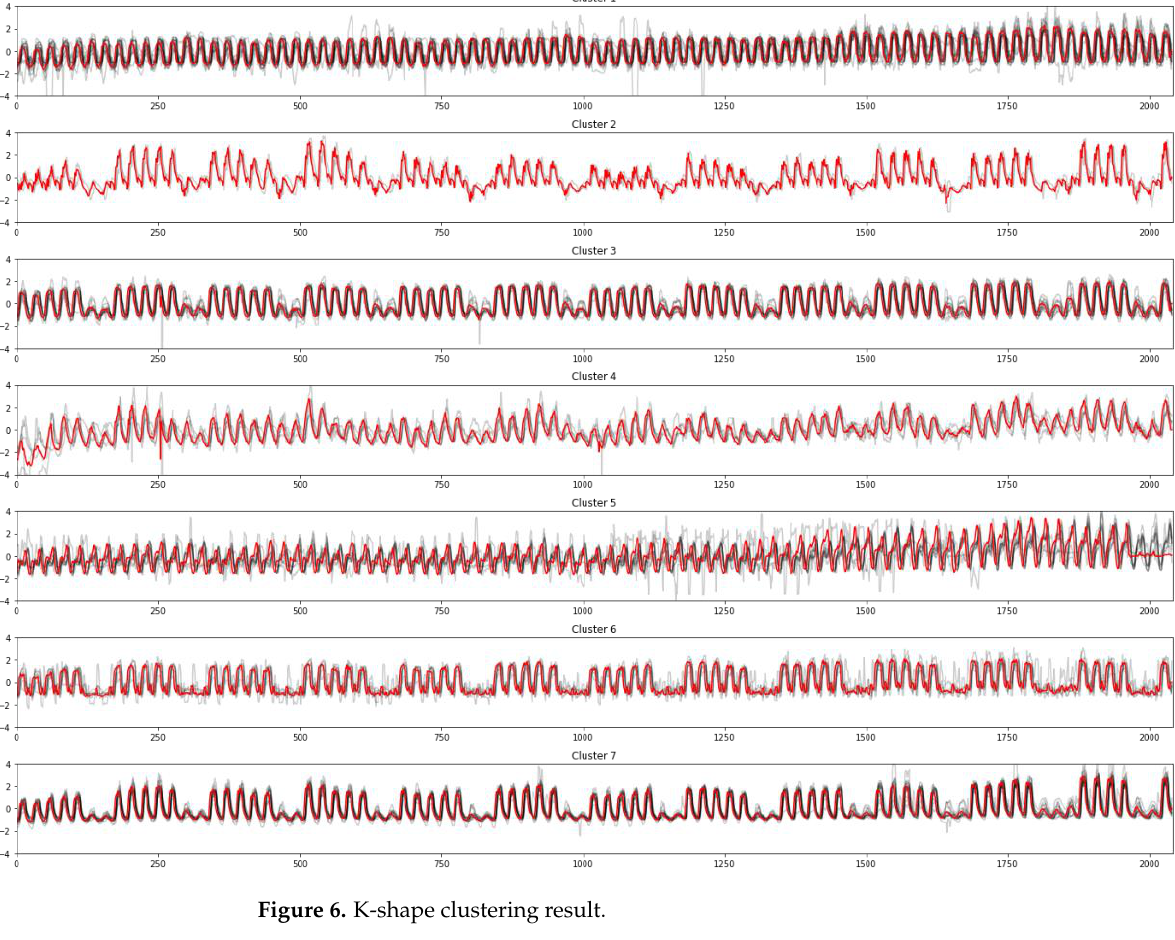
Figure 6. K-shape clustering